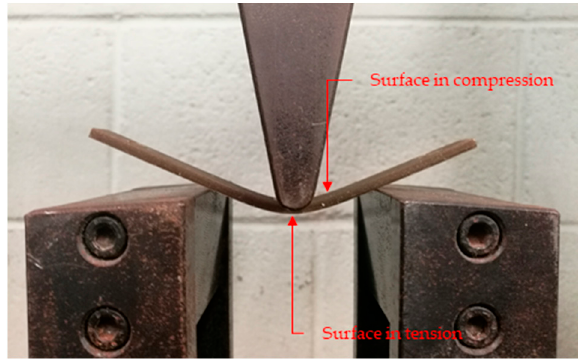
Figure 10. Combination of compressive and tensile loads during the three-point bending test.